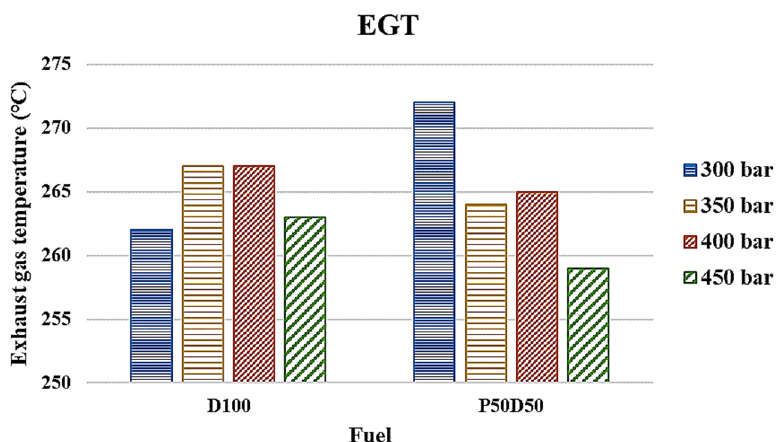
Figure 6. EGT under various injection pressures.